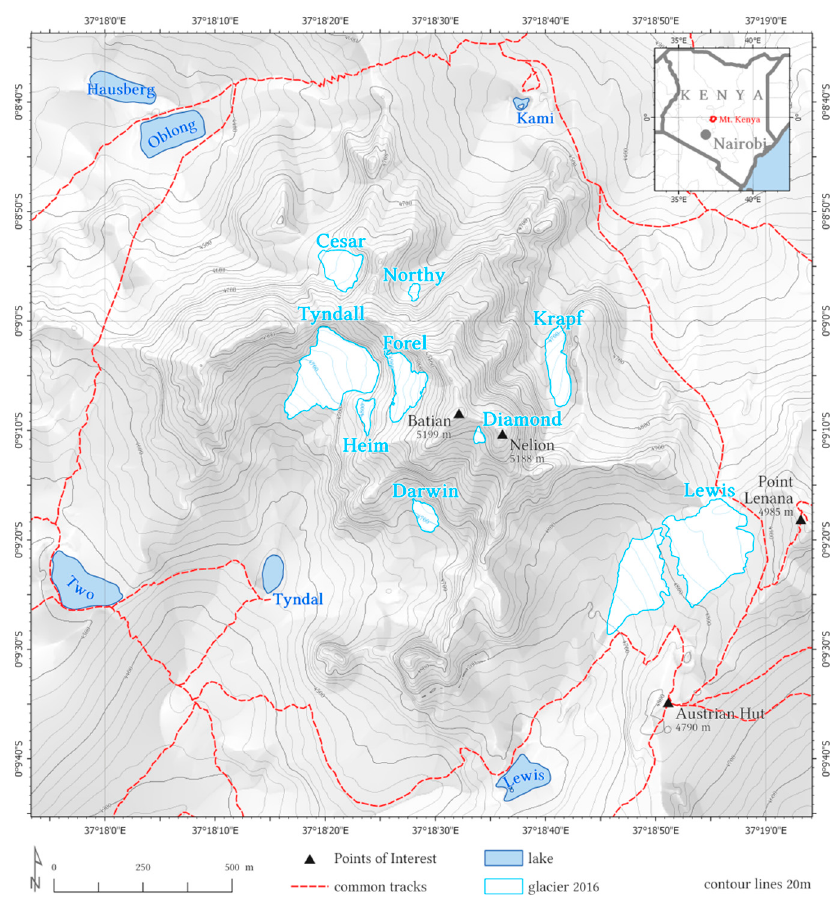
Figure 8. Overview of the glaciers of Mt. Kenya in their 2016 extent.